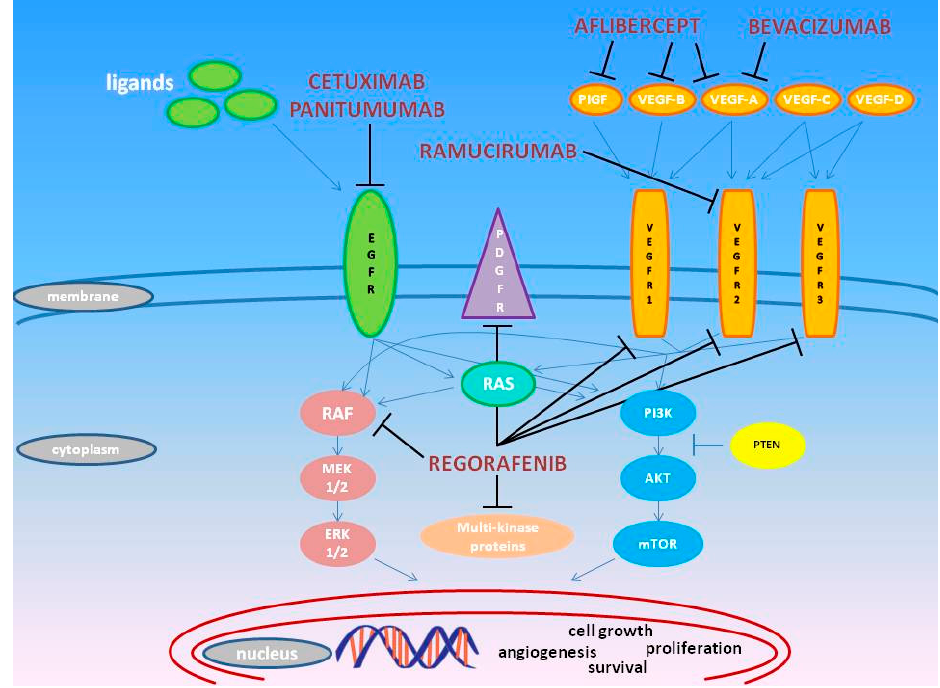
Figure 1. Molecular targets of the approved anti-EGFR and antiangiogenic agents (T arrows) in the EGF and VEGF molecular cascade (blue arrows).